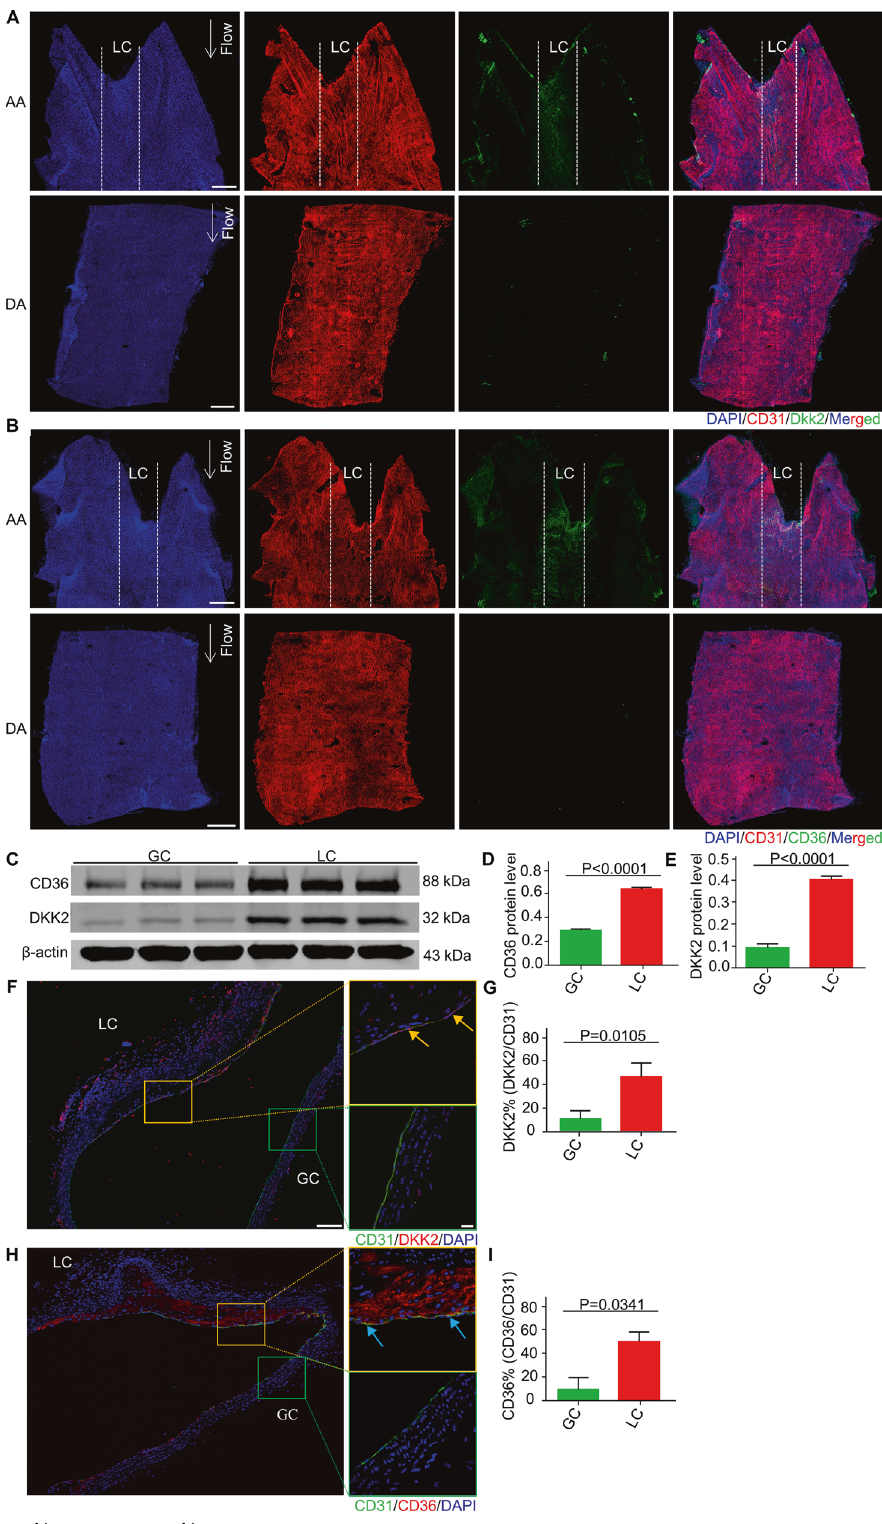
Fig. 6 Detection of Dkk2 hi ECs and Cd36 hi ECs in mouse aorta. A Representative en face immunostaining images for DKK2 in the aortic arch (AA) and the descending aorta (DA) of wild-type mice (blue: DAPI; red: CD31; green: DKK2). LC indicates lesser curvatures of the aortic arch. bar = 400 µm. B Representative en face immunostaining images for CD36 in the aortic arch (AA) and the descending aorta (DA) of wild-type mice (blue: DAPI; red: CD31; green: CD36), bar = 400 µm. C – E The DKK2 and CD36 protein expression in the greater (GC) and lesser (LC) curvatures of wild-type mice aortic arch was analyzed by Western blotting, normalized to β -actin. Data are mean ± SD. F-I Representative immuno fl uorescence microscopy images and its statistical analysis for DKK2 or CD36 in the aortic arch of ApoE − / − mice on a high-fat diet (9 weeks), bar = 100 µm. The magni fi ed image was shown on the right, bar = 20 µm.